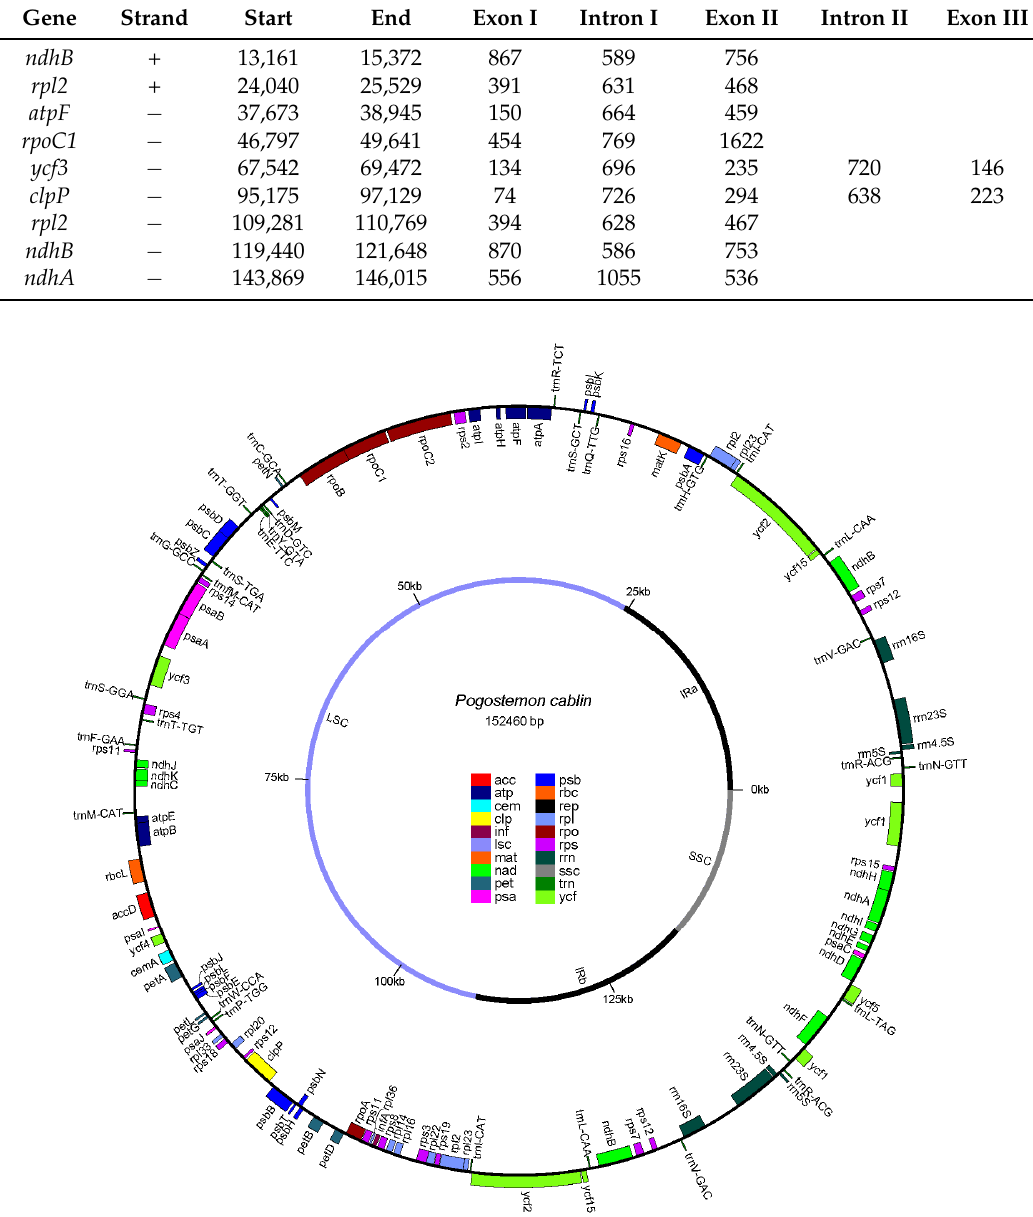
Table 1. The introns and exons length of intron-containing genes.